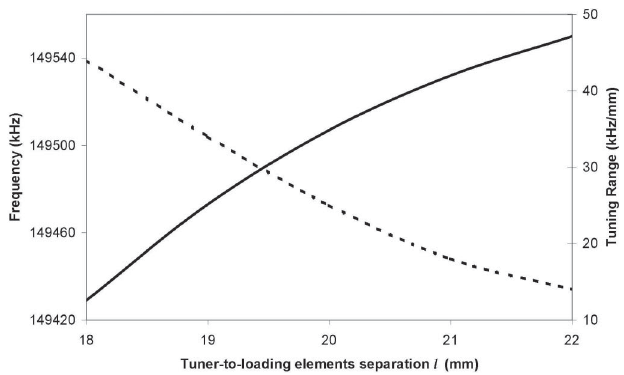
FIG. 11. Resonator frequency responses, calculated with MWS, of a 20 (cid:7) 100 mm flat displacement tuner (solid line) and tuning range (broken line) as a function of tuner-to-loading elements separation l .